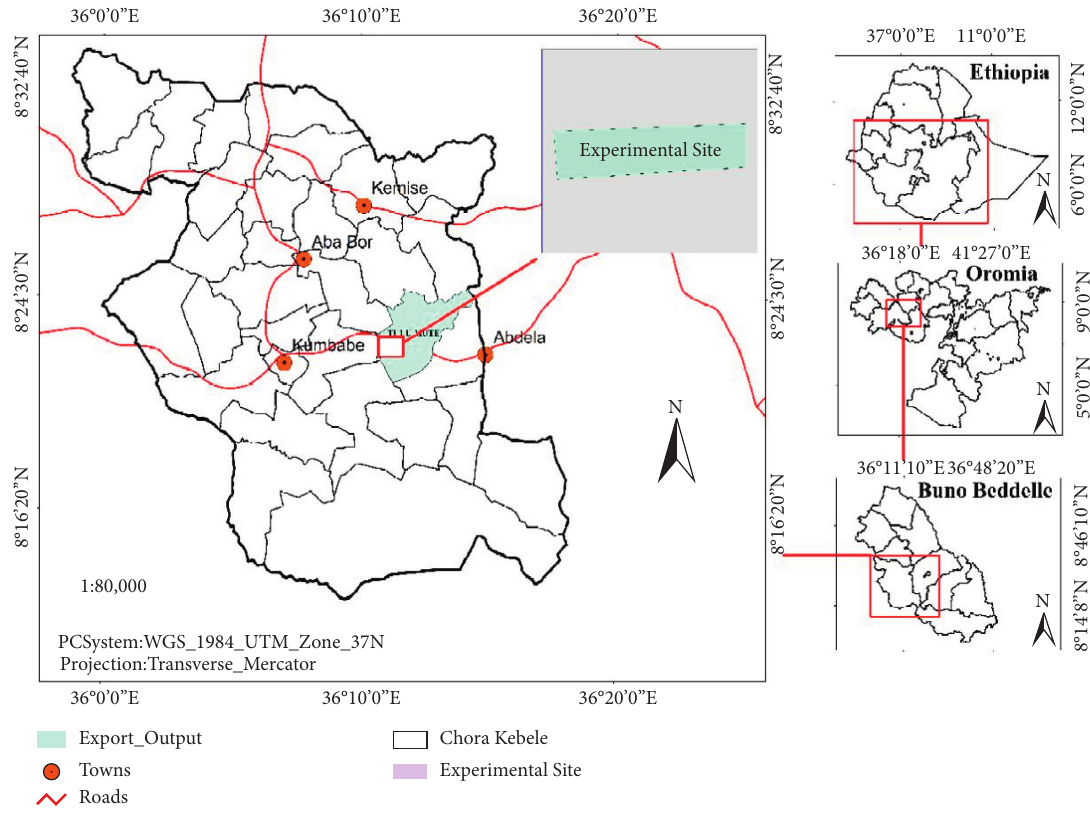
Figure 1: Map of study area. Table 1: Preplanting selected soil physicochemical properties of experimental